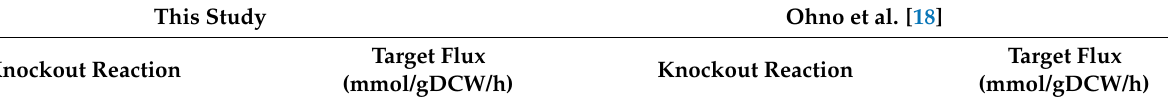
Table 2. List of reaction deletions proposed by Ohno et al. [20] and those proposed in this study for the production of L -Phe. Both methods proposed three reaction deletion candidates in common. In addition to these three reactions, a minimum of four reactions required deletion in this study to confirm the production of L -Phe, with a production flux of 1.54 mmol/gDCW/h and a productivity of 36% of the maximum theoretical yield. Further deletion of transketolase (TKT1) was found to result in a production flux of 3.67 mmol/gDCW/h with an 86% yield.